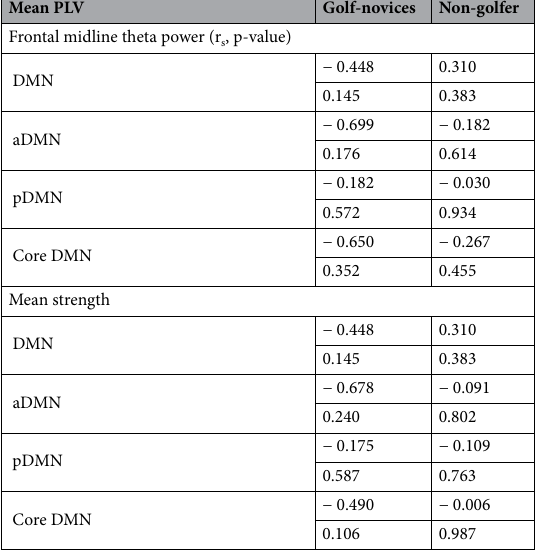
Table 3. Spearman correlations (r s ) between frontal midline theta power and connectivity of the DMN (Default Mode Network) for the golf-novices (n = 12) and non-golfer group (n = 10). aDMN anterior